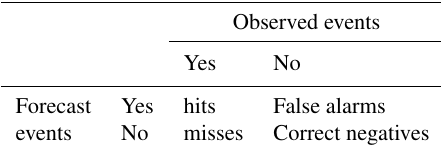
Observed events Yes